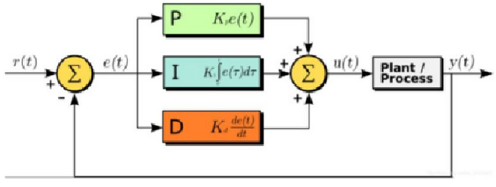
Figure 2. PID control law control structure